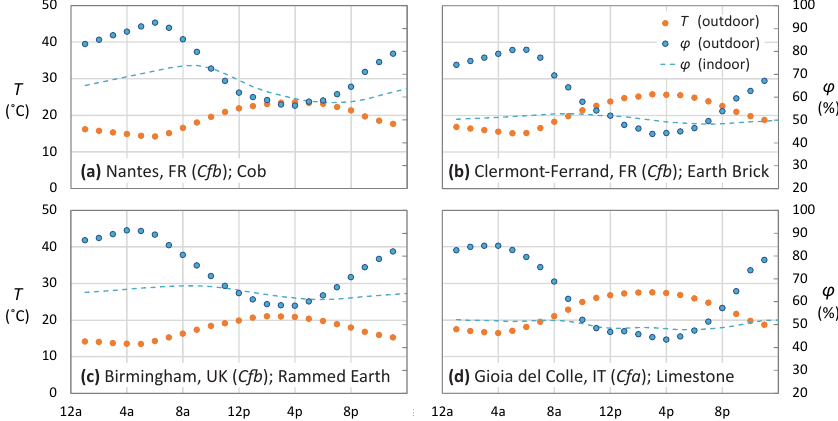
Figure 9. Climates used in simulations of intrinsic evaporative cooling, and indoor relative humidity levels maintained, by ( a ) cob (Nantes, France); ( b ) unfired earth bricks (Clermont-Ferrand, France); ( c ) rammed earth (Birmingham, UK); and ( d ) limestone (Gioia del Colle, Italy). Dots show average hourly July values of dry-bulb air temperature (orange) and relative humidity (blue) in each climate; weather files are given in Table 3. Dashed lines show values for indoor relative humidity corresponding to walls or roofs of cob (10 cm thick, Figure 10), unfired earth bricks (Cagnon Earth Brick 1, Figure 11), rammed earth (of maximum D , Figures 15 and 16), and fine Apulian limestone (original, Figures 17 and 18). Note that simulations excluded interior latent heat sources (Section